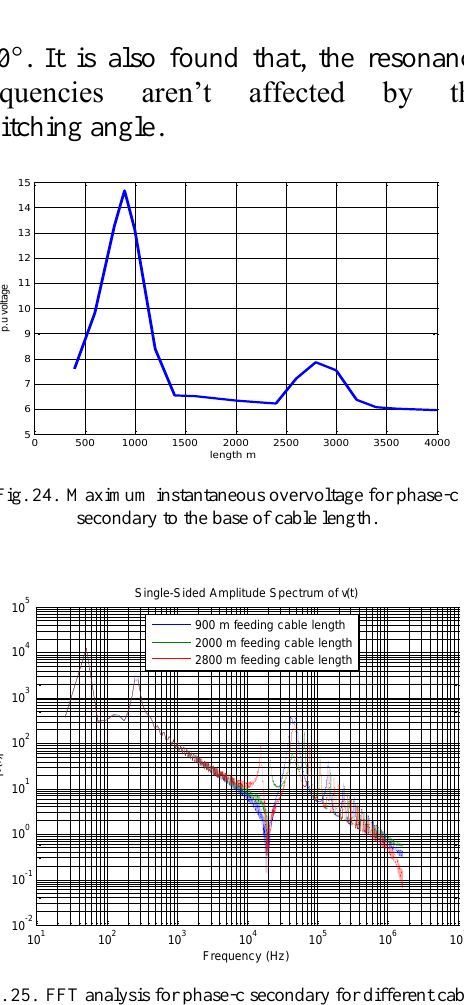
Fig. 25. FFT analysis for phase-c secondary for different cable lengths. 4.2 E FFECT OF C APACITOR S IZE AND SWITCHING SEQUENCE